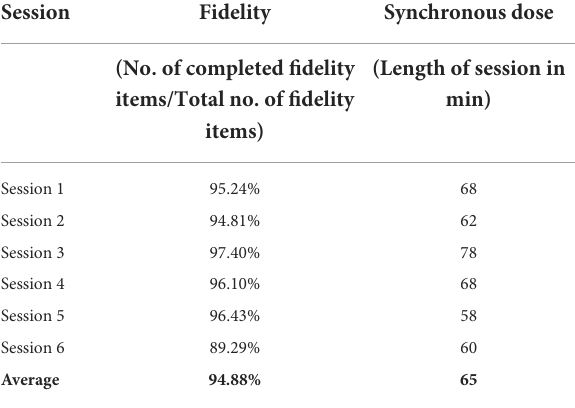
TABLE 5 Summary of iROLL-O’s reach.